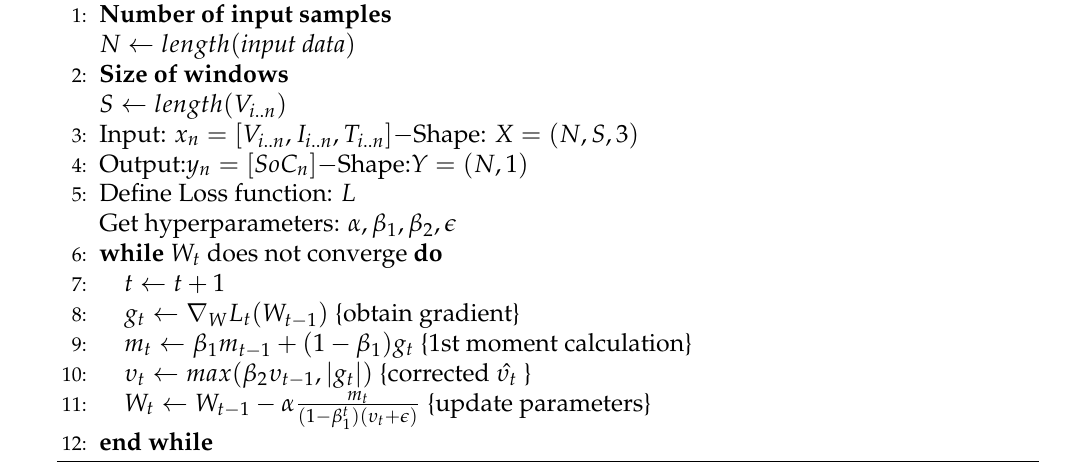
Algorithm 5 Adaptive moment estimation based on the infinity norm